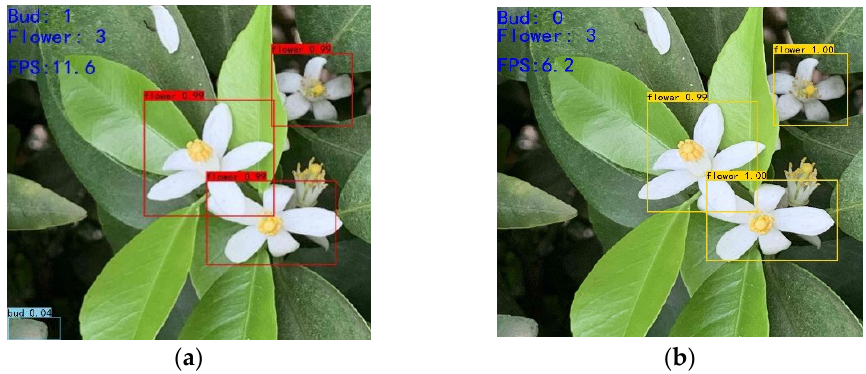
Figure 7. Comparison of real-time FPS detection between improved YOLOv4 and YOLOv4. ( a ) Improve YOLOv4 real-time FPS. ( b ) YOLOv4 real-time FPS.